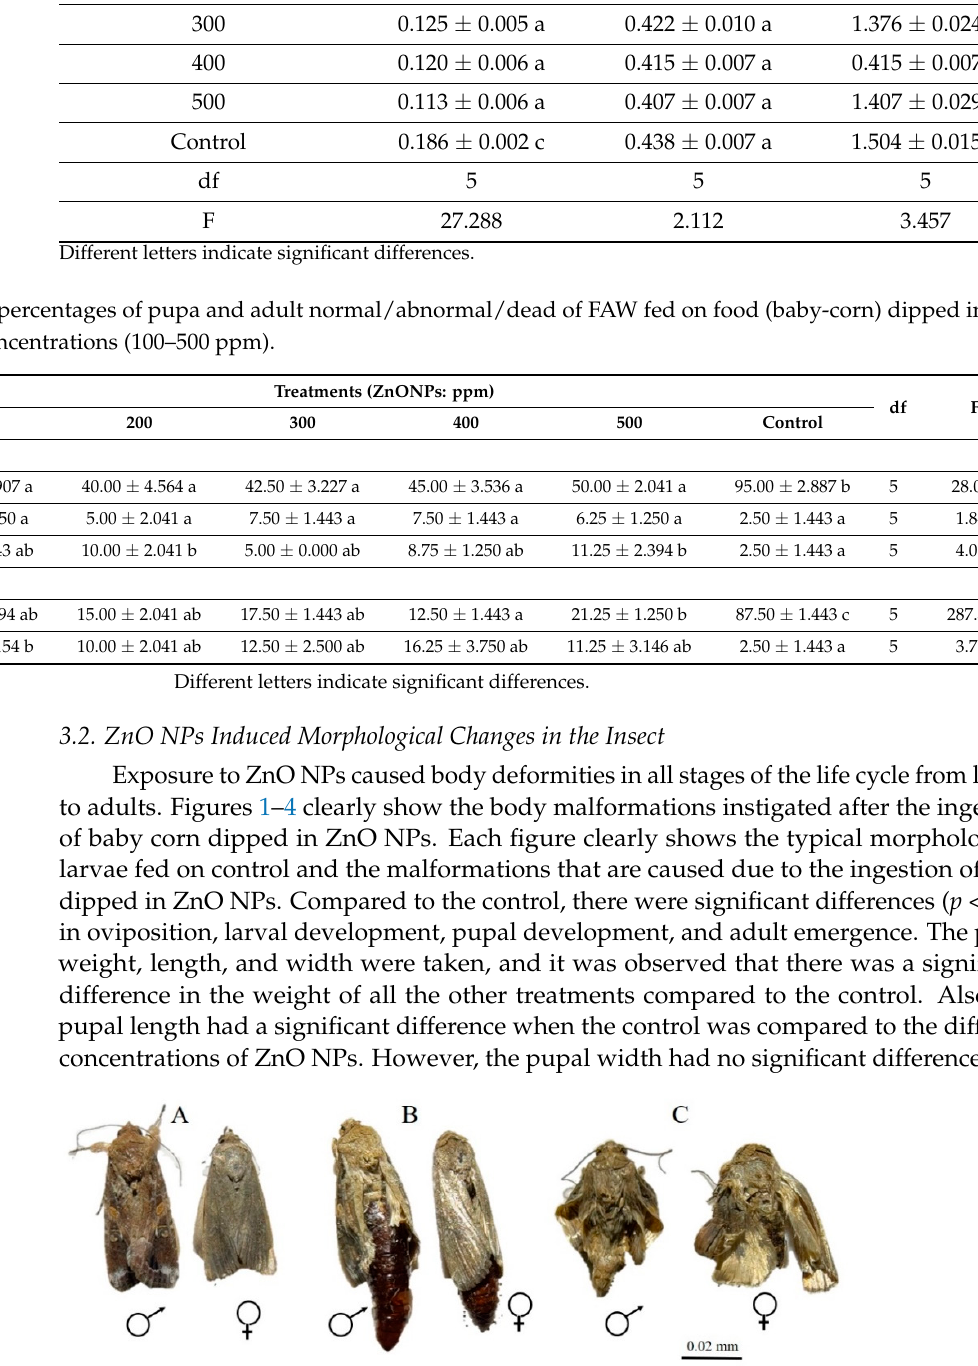
Figure 2. ( A ) Control 5th instar larvae; ( B , C ) Malformed 5th instar larvae. Figure 3 . ( A ) Control 6th instar larvae; ( B , C ) Malformed larvae 6th instar larvae. Figure 4. ( A ) Control pupa; ( B , C ) Malformed pupa.